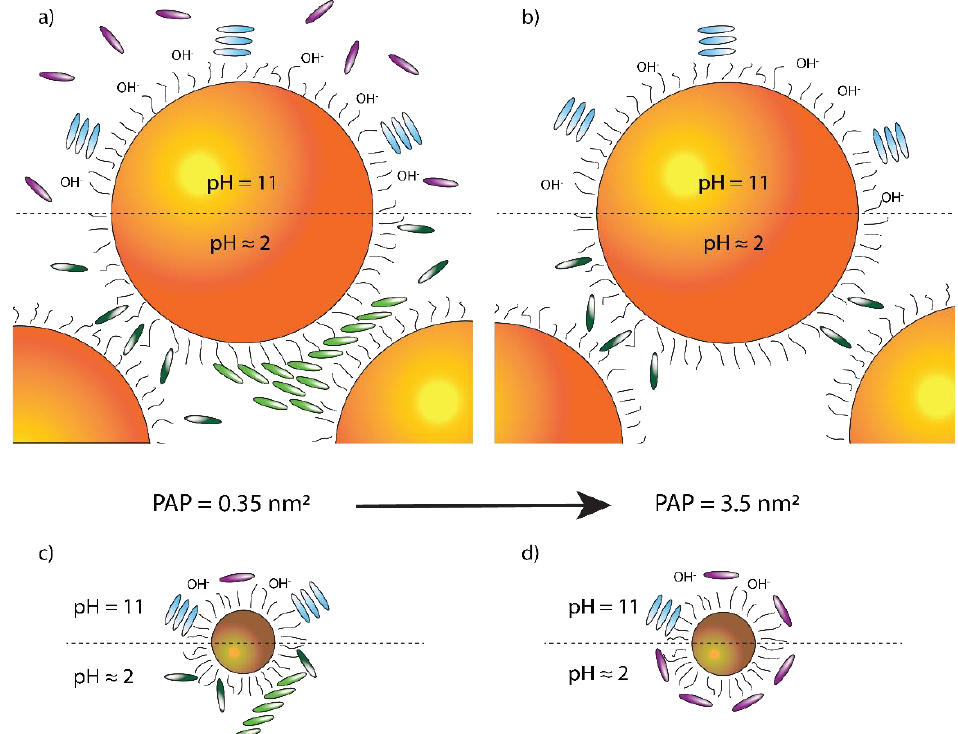
Figure 9. Overview of the interactions between NPs and porphyrin dyes. The structures templated by BNPs and SNPs are schematized in panels ( a ), ( b ), ( c ), ( d ), respectively. Interactions at pH = 11 (pH = 2.2) are at the top (bottom) of each image. Panels ( a ) and ( c ) refer to PAP = 0.35 nm 2 , while panels ( b ) and ( d ) to PAP = 3.5 nm 2 . Each porphyrin species is pinpointed by a different color: monomeric TPPS 4− (H 2 TPPS 2− ) is violet (dark green), while H (J) aggregates are light blue (light green).